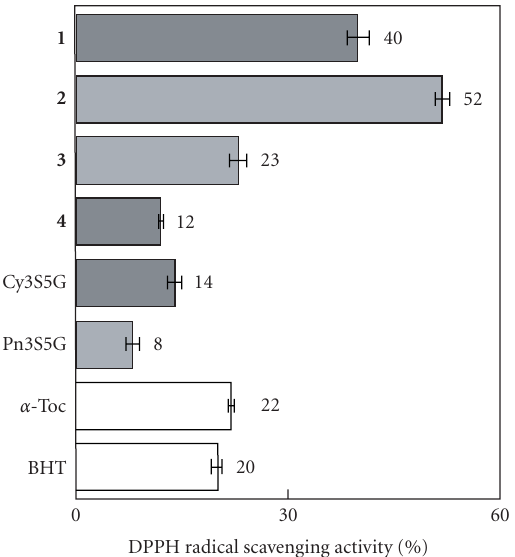
Figure 4. DPPH radical scavenging activity (%) of purple sweet potato callus anthocyanins 1 , 2 , 3 , and 4 (pH 7 . 4 at room tem- perature). α -Toc = α -tocopherol and BHT = 2,6-di- tert -butyl-4- methylphenol. Each value is the mean (RS%) ± standard devia- tion (n = 4). Figure 3, diacylated anthocyanins (t 1 / 2 of 2 : 266 minutes, 3 : 180 minutes, and 4 : 337 minutes) were more stable than monoacylated 1 (t 1 / 2 = 37 minutes), and nonacy- lated Cy3S5G (t 1 / 2 = 15 minutes) and Pn3S5G (t 1 / 2 =